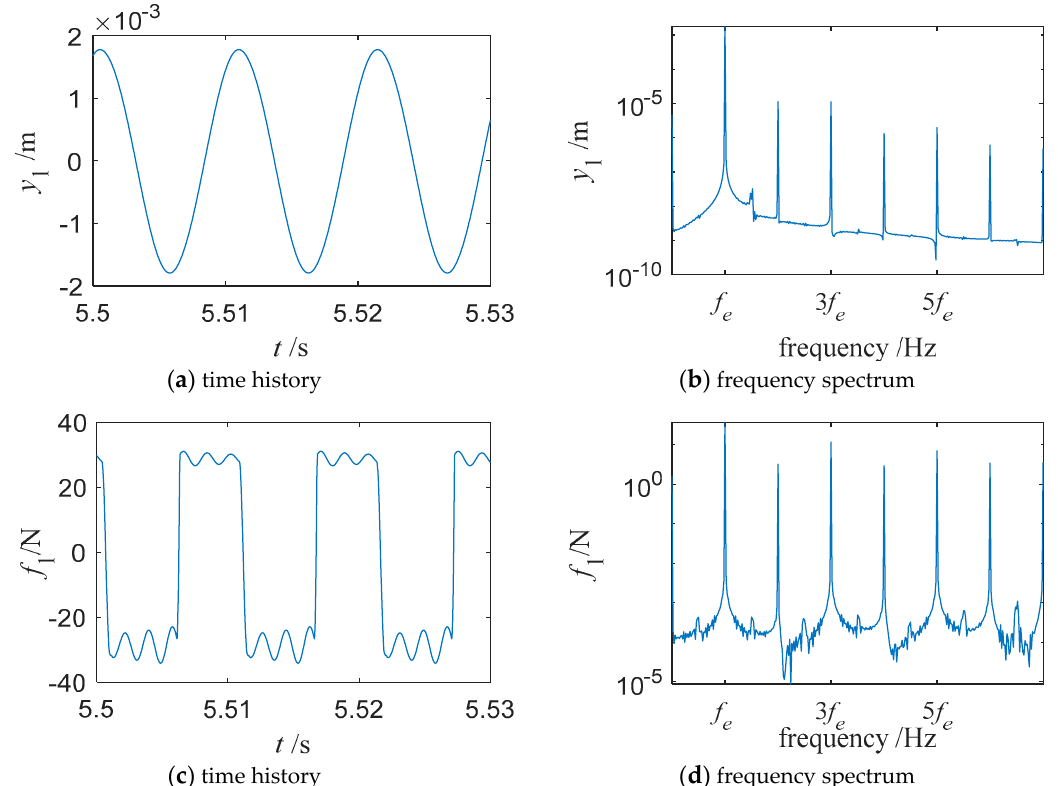
Figure 6. Steady-state dynamic characteristics of the response ( a , b ) and dry friction force ( c , d ). 2. The parameters are taken from Table 3. Figures 7 and 8 show the simulation results. Table 3. The parameters of the system.